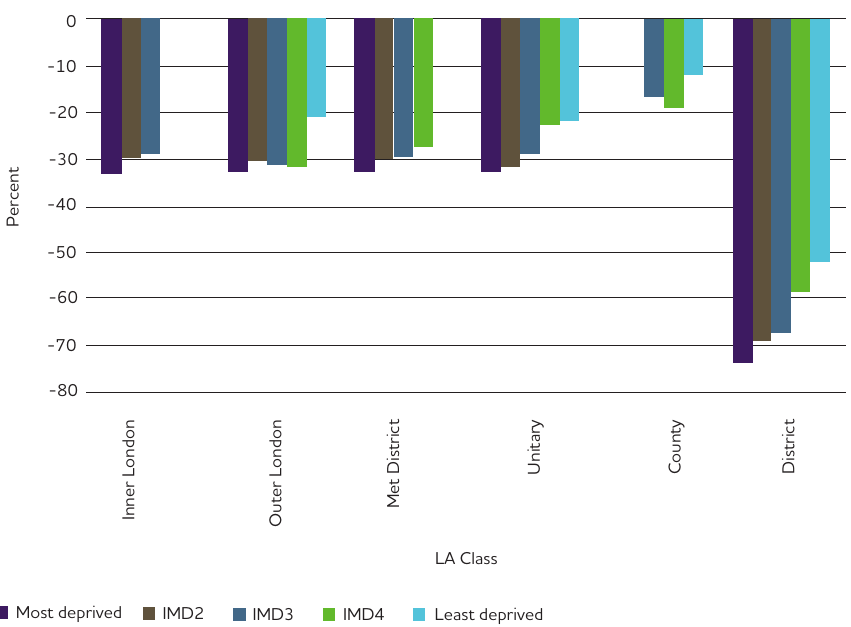
12 The cost of the cuts: the impact on local government and poorer communities